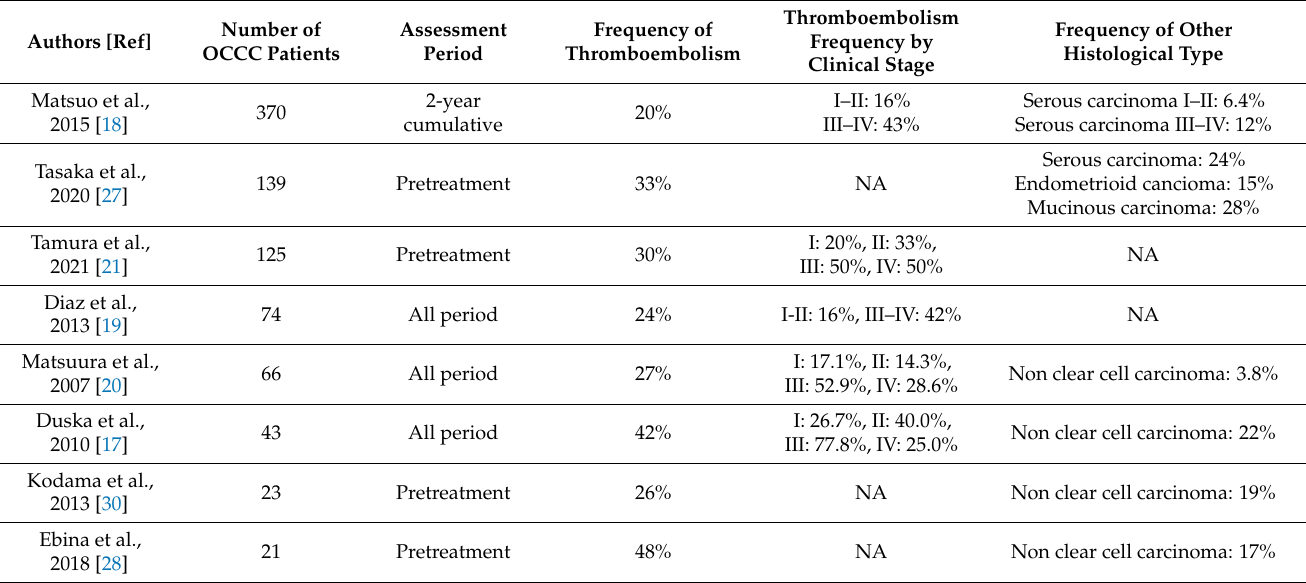
Table 1. Previous studies about the prevalence of cancer-associated thrombosis in